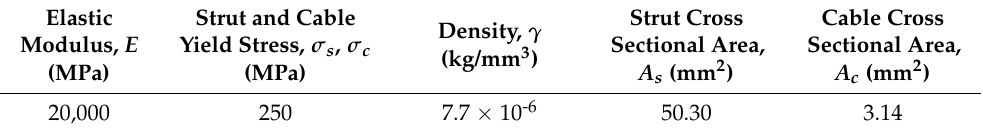
Table A2. Material